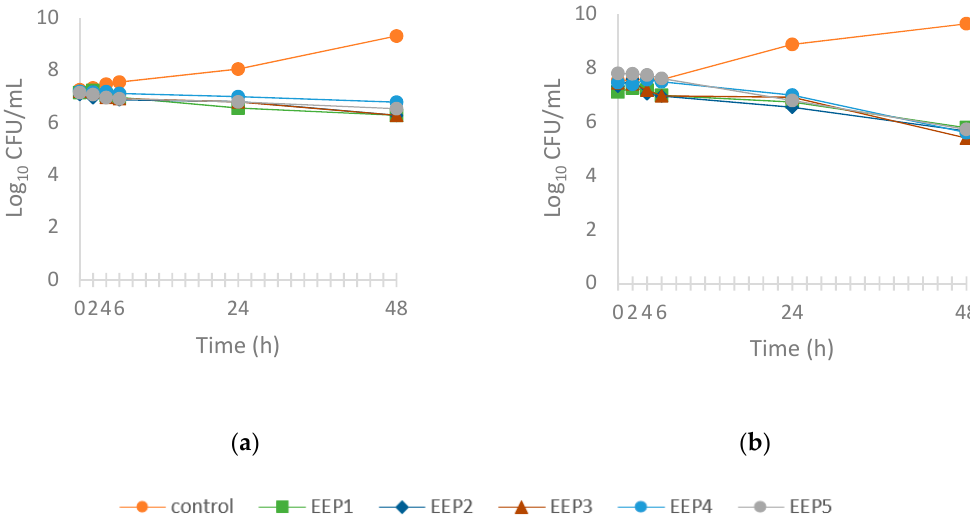
Figure 3. Time-kill curves of ethanol extracts of propolis against yeast. ( a ) R. mucilaginosa , ( b ) C. albicans